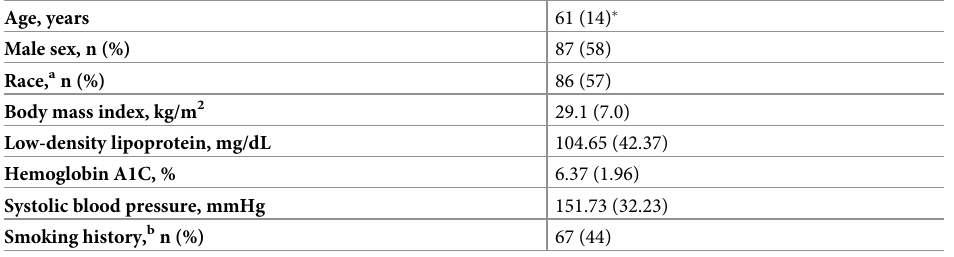
Table 1. Demographic characteristics and ischemic stroke risk factors of patients at baseline (N =